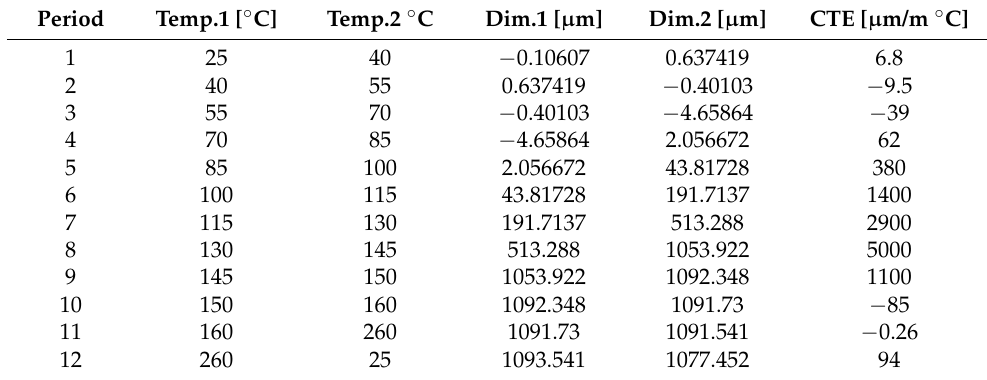
Table 1. CTE of PPG in an x direction.